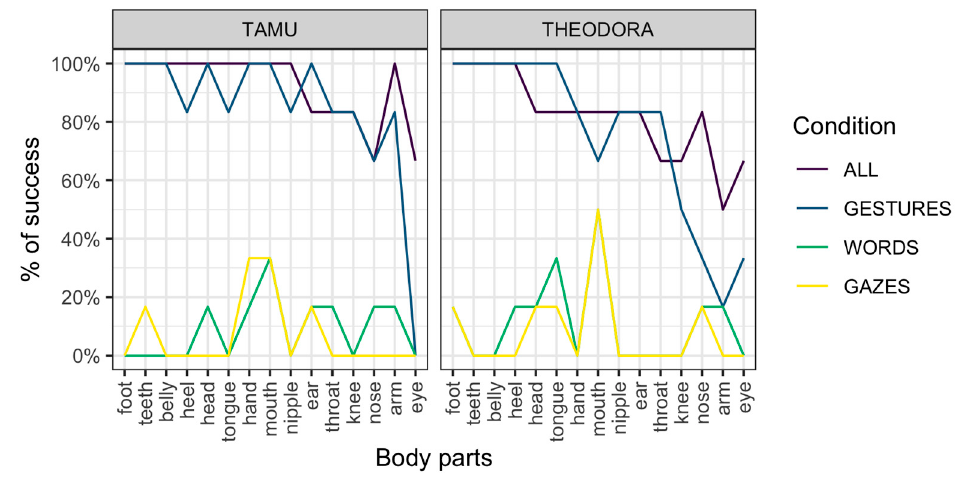
Figure 2. Performance for the two subjects across conditions and requested body parts.